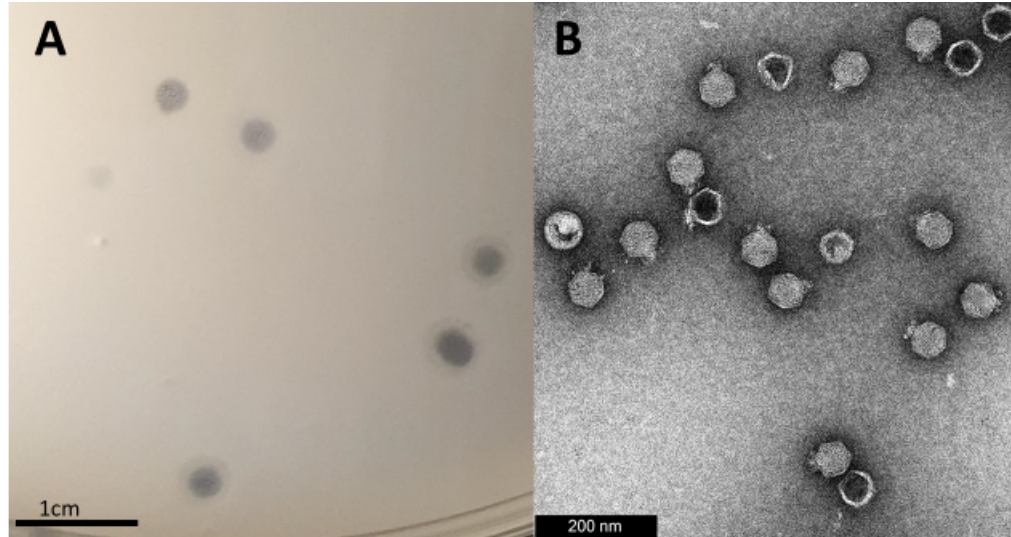
Figure 1. ( A ) Plaque morphology of Proteus _virus_309 showing a clear zone with a slight halo border. ( B ) Transmission electron micrograph of Proteus _virus_309 displaying icosahedral morphology with several damaged or empty viral particles represented by capsids with a darker center (less electron dense).